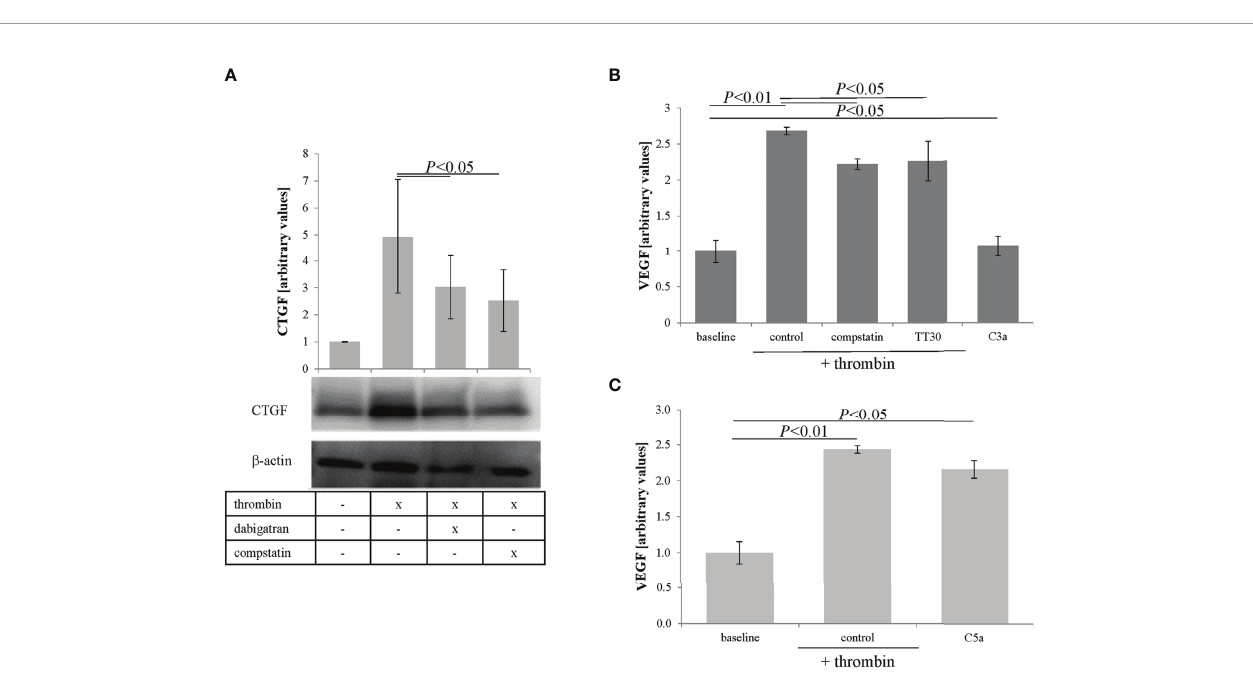
FIGURE 6 | CTGF and VEGF expression can be regulated by complement. (A) Thrombin-mediated CTGF expression in cells can be inhibited by fl uid phase complement inhibition (compstatin). (B) VEGF secretion into the apical supernatant as measured by ELISA was induced by thrombin, partially reduced by fl uid phase or membrane- based complement inhibition (100 m M) and partially induced by C3a receptor activation (C3a, (260 nM). (C) C5a receptor stimulation (C5a, 52 nM) was as potent as thrombin treatment when assessing the amount of VEGF secreted into the apical supernatant. Data are plotted as mean ± SEM; n = 3 independent